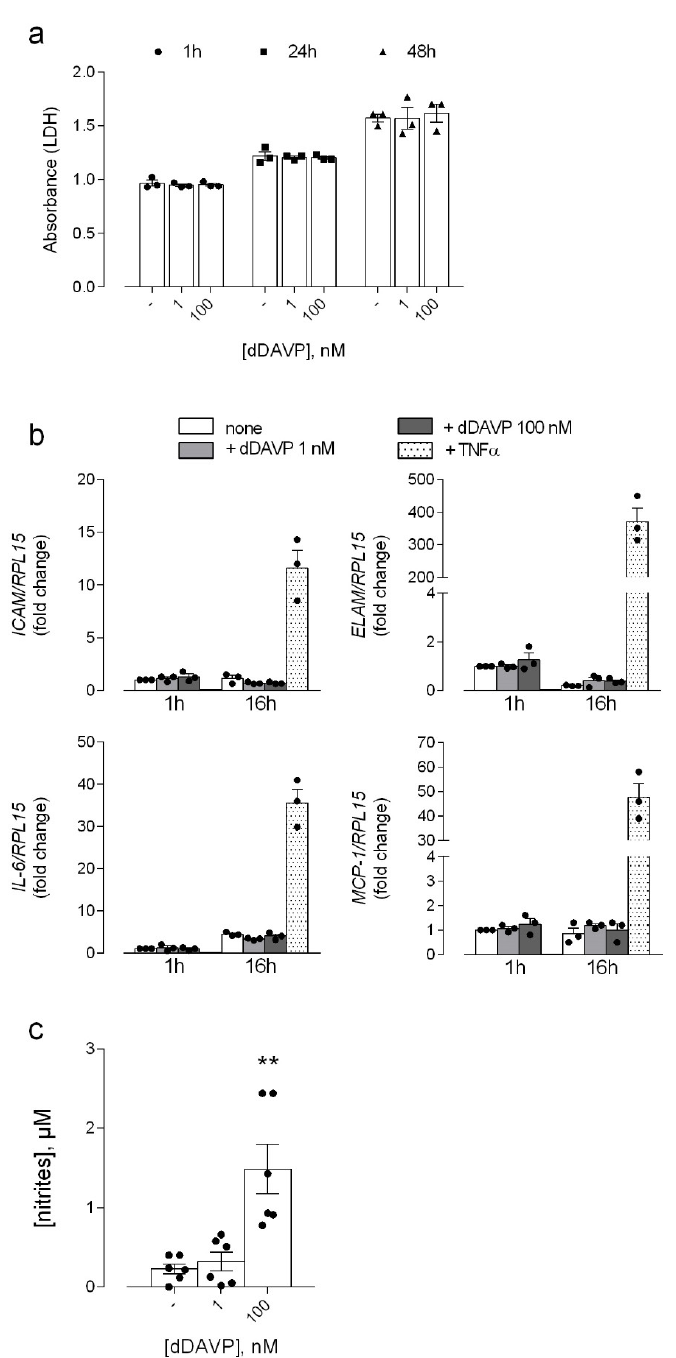
Figure 1. Effects of desmopressin on the viability and activation of microvascular endothelial cells. HLMVEC were incubated for the indicated times with different concentrations of dDAVP, as shown. ( a ). After the treatment, LDH release was assayed in the incubation medium as described in Methods. Data are the means ± SEM of four independent experiments each performed in triplicate. ( b ). The expression of the indicated genes was measured by means of RT-qPCR with the ∆∆ Ct method and normalized for that of the housekeeping gene RPL15 (see Material and Methods). The stimulation with 10 ng/mL TNF α was employed for comparison, as positive control. ( c ). The production of NO was assessed through the quantitation of nitrites in the incubation medium, as described in Material and Methods. Data are means ± SEM of six independent determinations. ** p < 0.01 vs. control (-) with a two tailed Student’s t -test for unpaired